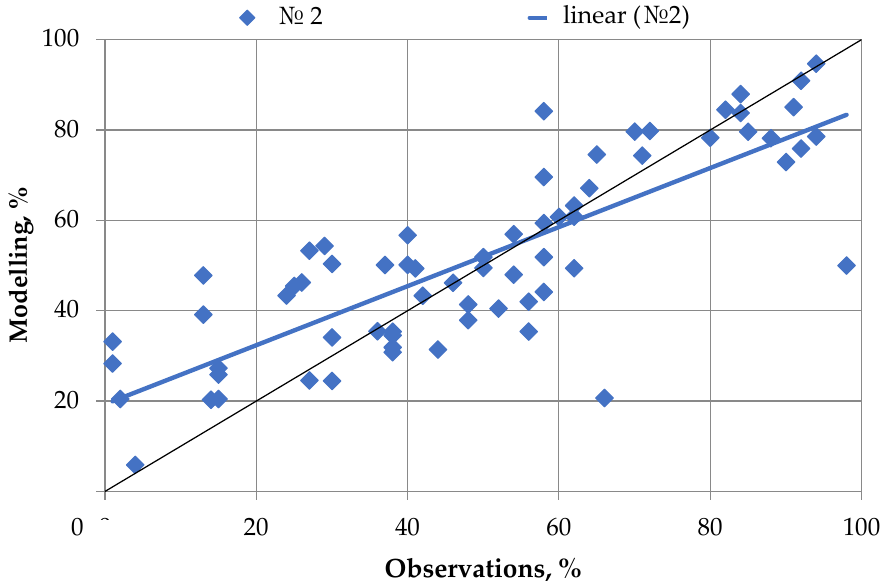
Mining 2022 , 2 , FOR PEER REVIEW 10